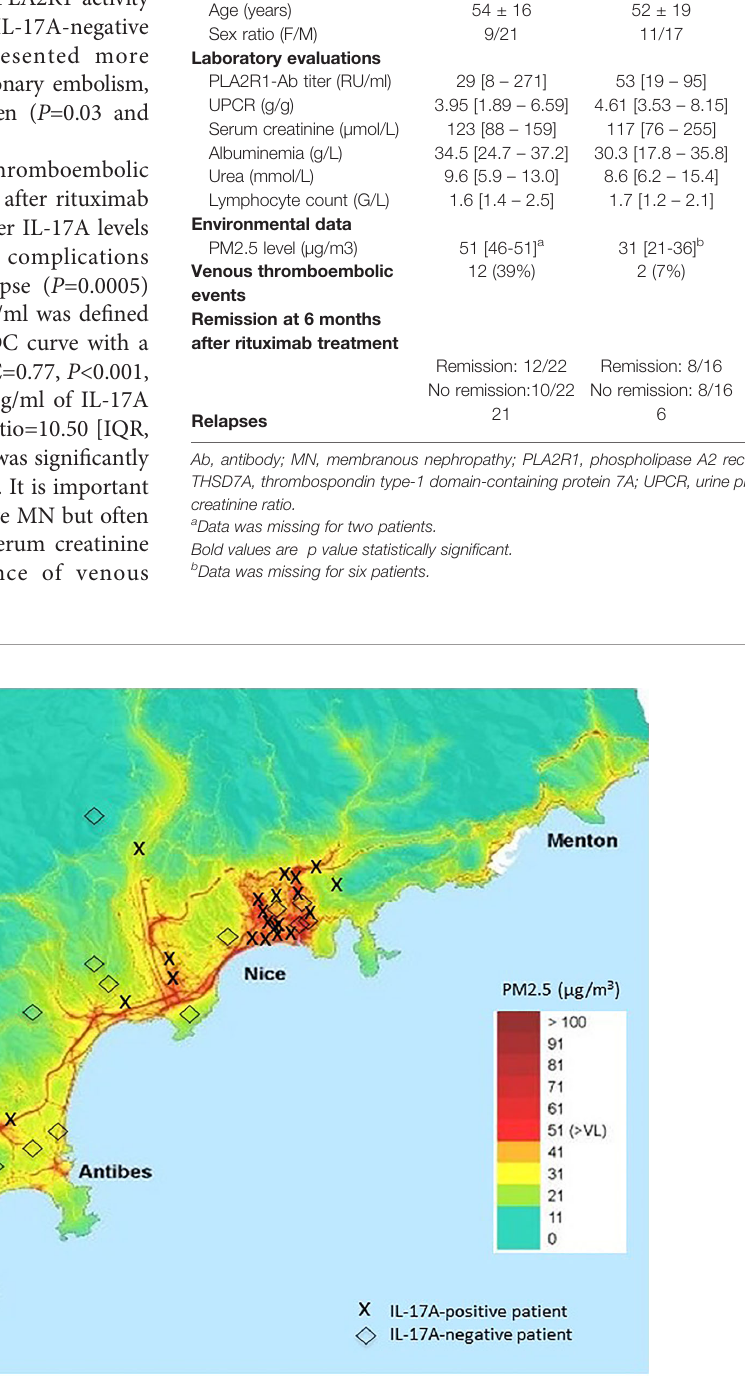
FIGURE 3 | Superposition of the usual area of residence of membranous nephropathy (MN) patients and air pollution. Cumulative PM 2.5 exposition in 2016 in the French region Provence-Alpes-Co ̂ te d ’ Azur is presented as heat map. The usual area of residence of each MN patient living in the French region Provence-Alpes- Co ̂ te d ’ Azur is represented by a cross (IL-17A-positive MN patients) or a rhombus (IL-17A-negative MN patients). IL, interleukin; PM, particulate matter.